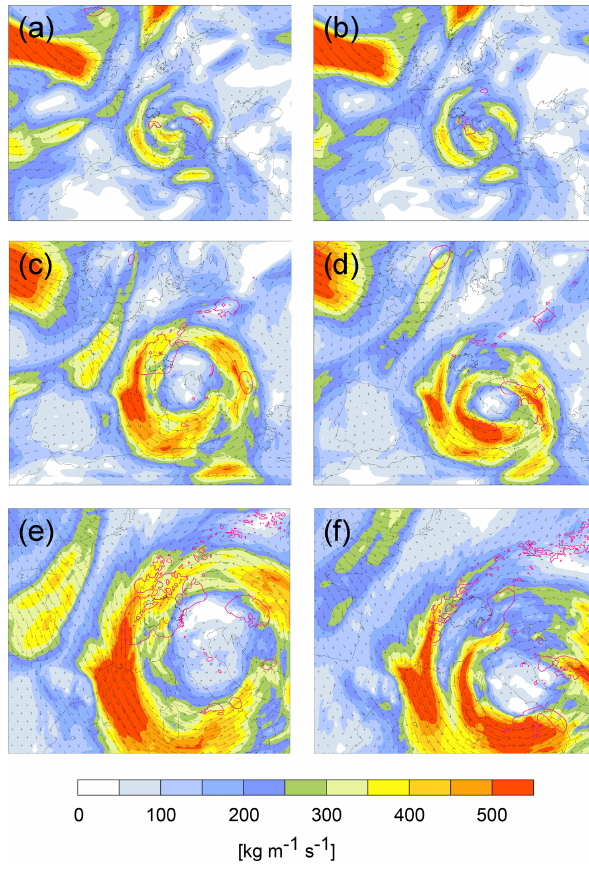
Figure 6. IVT (kgm − 1 s − 1 ) on 22 August 2005 18:00UTC for in the WRF 81km (a, b) , 27km (c, d) , and 9km (e, f) domains and for a member producing maximum (#24; see Fig. A2; a , c , e ) and minimum (#50; b , d , f ) precipitation totals. Smoothed hourly pre- cipitation is shown with pink contours of 0.2 and 1mmh − 1 .